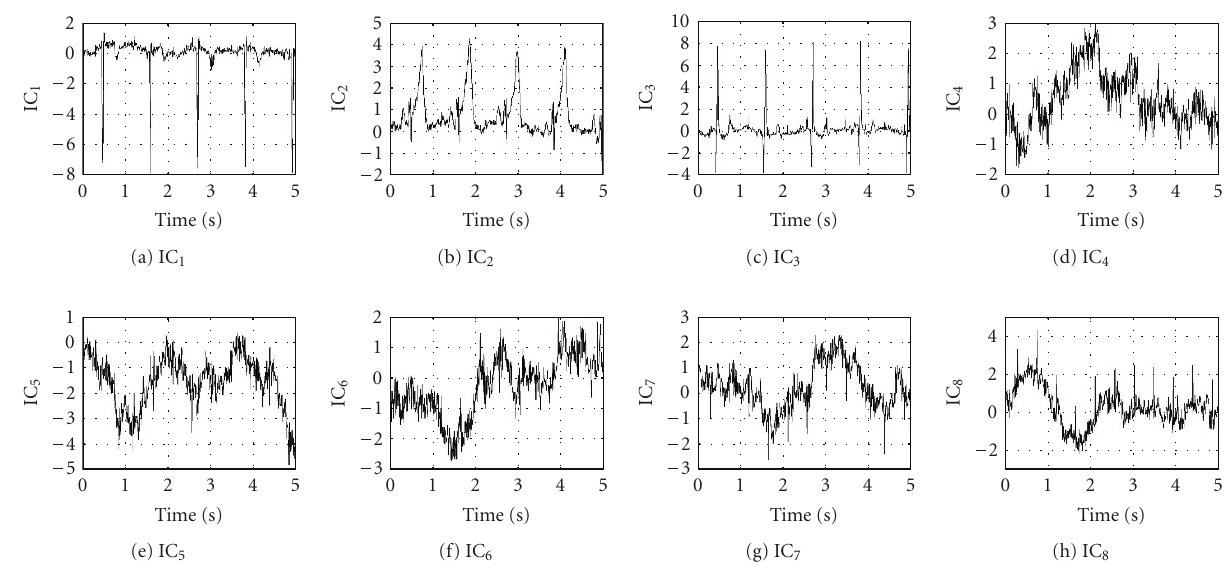
Figure 11: Independent components (ICs) extracted from the synthetic multichannel recordings. Strong maternal presence can be seen in the first three components. Fetal cardiac activity can be clearly seen in the last three